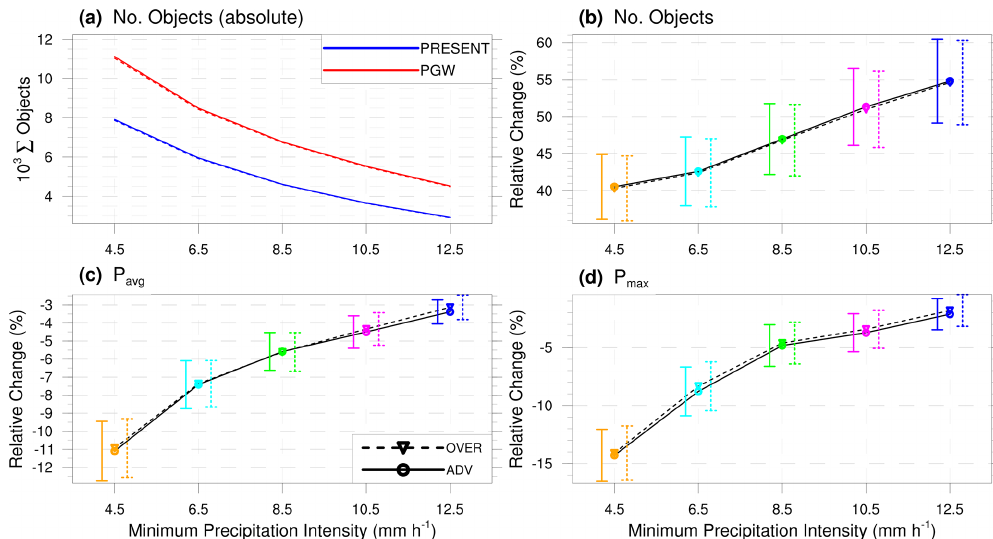
Figure 5. Climate-change signals of P avg , P max and N obj as a function of the object’s minimum-precipitation-intensity ( P min ) criterion, for both algorithms. Change signals which are different with statistical significance at the 0.95 level can be identified based on non-overlapping CIs (Sect. 3.4), seen as vertical solid (advection) or dashed (overlap) lines. In panel (a) , the numbers of objects are shown (i.e. the sample sizes). P min is shown as the equivalent hourly rate based on 5min intensities. The climate-change signals of the remaining object properties, as well as the values underlying them, can be seen in Figs. S3 and